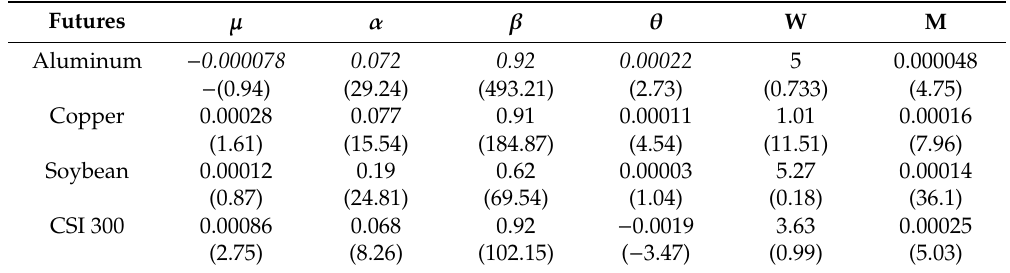
Table 8. Parameter estimates of one side GARCH-MIDAS model with producer price index (PPI).